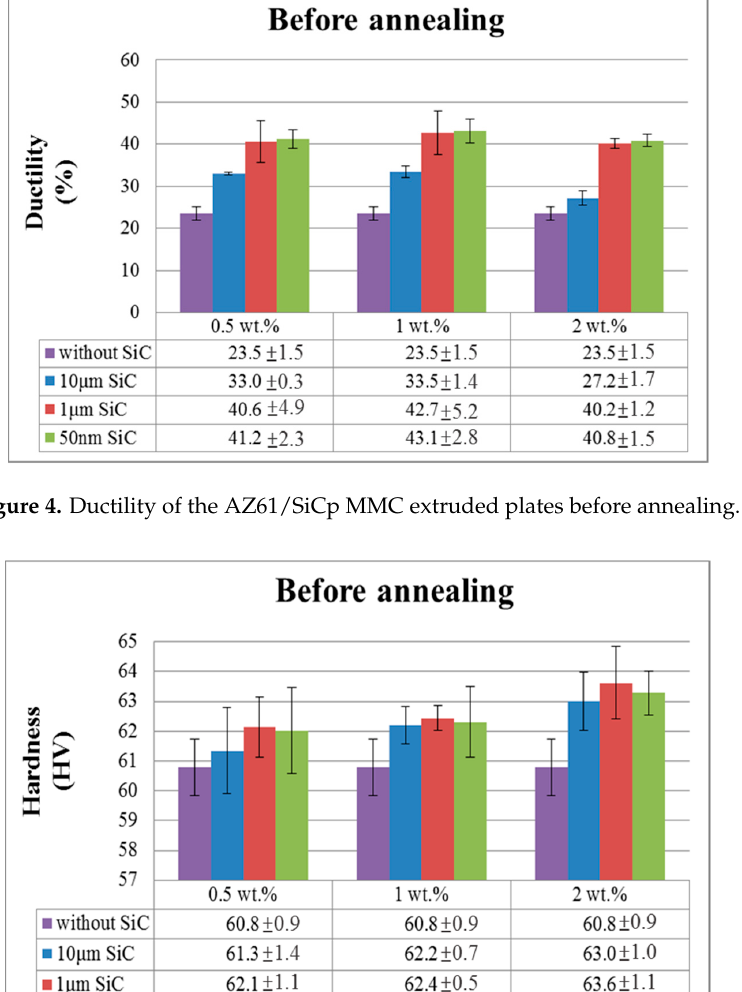
Figure 3. Yield strength of the AZ61/SiCp MMC extruded plates before annealing.